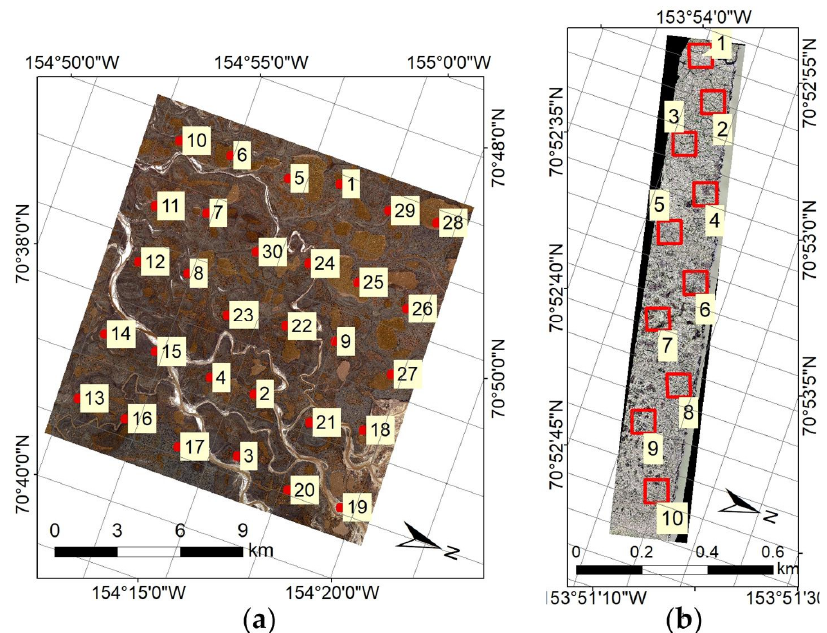
Figure 2. Locations of performance assessment of the thirty ( a ) and ten ( b ) subsets (red squares) from the satellite and UAV images.